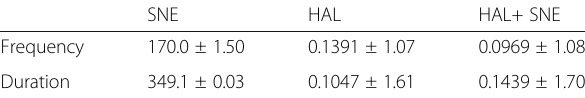
Table 1 ED 50 values (mg/kg) ± SEM of SNE, haloperidol (HAL) and haloperidol (HAL) (0.1, 0.3, 1.0 mg/kg, i.p) + SNE (100 mg/kg, p.o) [HAL + SNE] on the frequency and total duration of